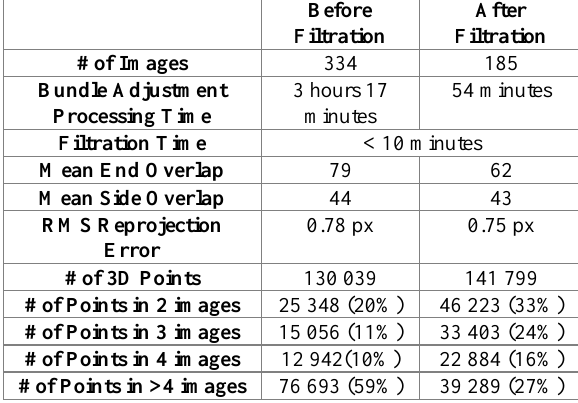
Table 5. Results of the filtration test on the single grid dataset. Table 6. Results of the filtration test on the criss-cross